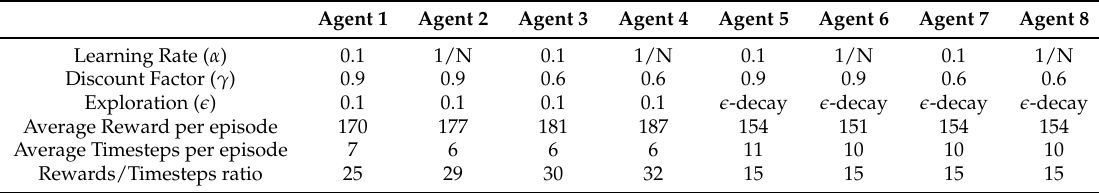
Table 1. Performance of 8 agents with different hyperparameter values, after 100,000 epochs training using Reward Shaping I.